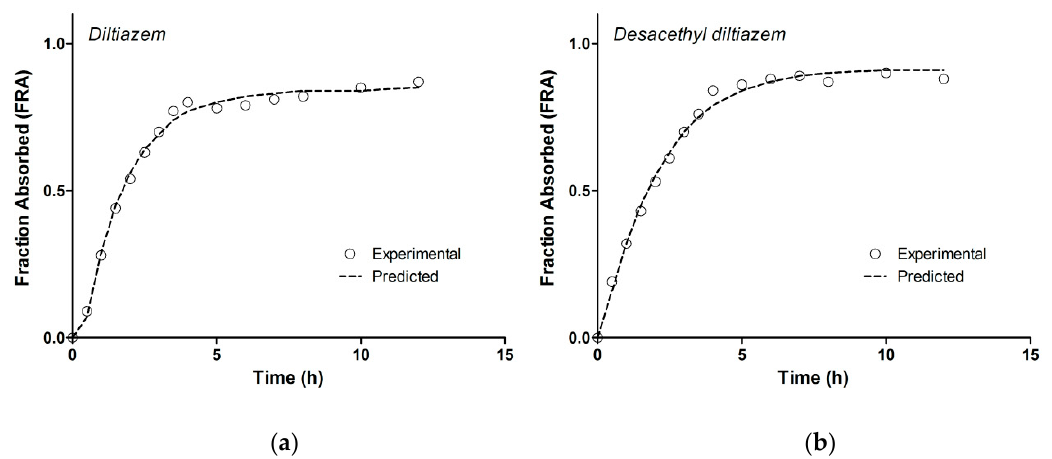
Figure 7. Fraction absorbed profiles calculated for ( a ) DTZ and ( b ) DTZM; observed: profiles calculated based on estimation of elimination rate constant with non-compartmental analysis, predicted: profiles calculated based on estimation of elimination rate constant with one-compartmental pharmacokinetic modeling.